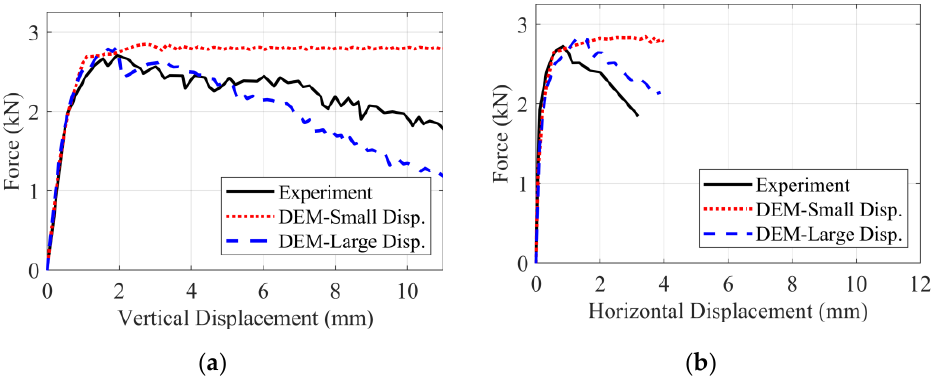
Figure 8. Comparison of the force-displacement curves between the experiment and DEM-based models (including small and large displacement analysis); ( a ) vertical displacement, ( b ) horizontal displacement.